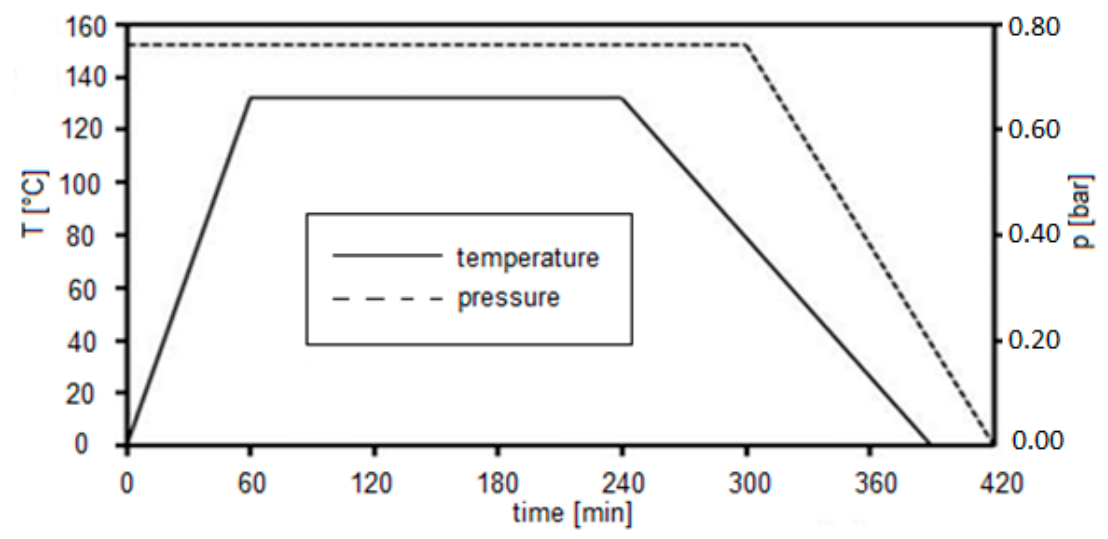
Figure 4. Curing cycle 1 in the sample production.